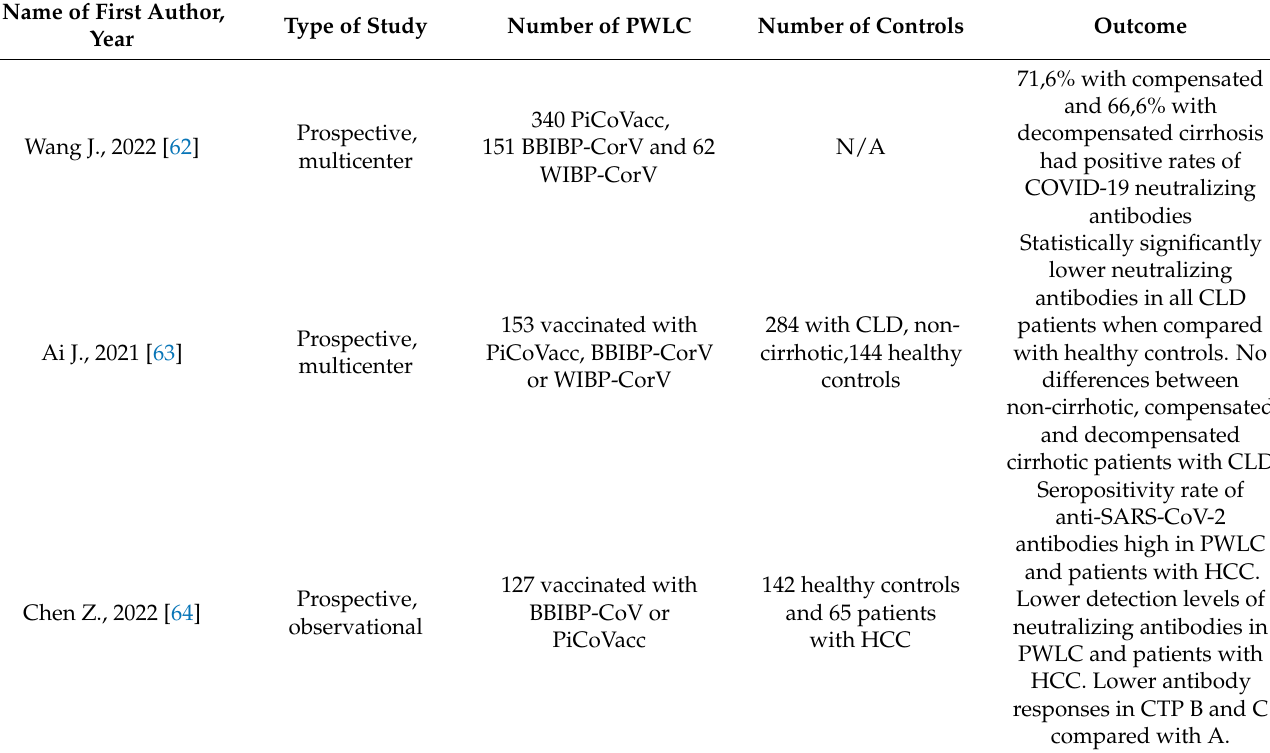
Table 3. Most important studies concerning whole virion anti-SARS-CoV-2 vaccines in patients with